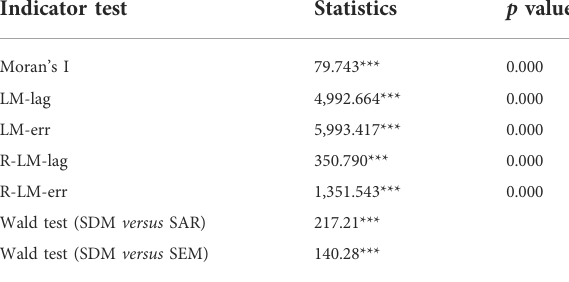
TABLE 3 Model inspection